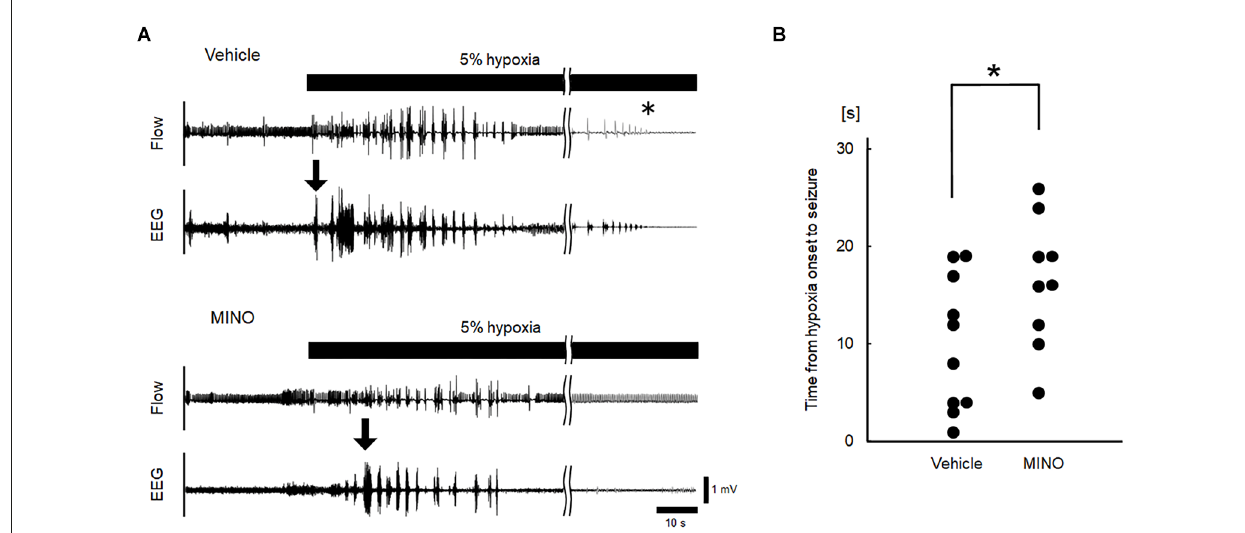
FIGURE4 Inhibition of microglial activation delayed the occurrence of seizures. (A) Representative raw recordings of respiratory flow (inspiration upward) and EEG signals in hypoxia experiments without and with minocycline. Seizures were accompanied by high amplitude aberrant waves in EEG (the onset of seizures was indicated by downward arrows). The time of respiratory arrest was indicated by an asterisk. (B) Time from the onset of hypoxia to seizures in vehicle and minocycline pre-treated mice. Time to seizure was significantly longer in the latter group of mice (Mann-Whitney U test). MINO, minocycline. ∗ p < 0.05.